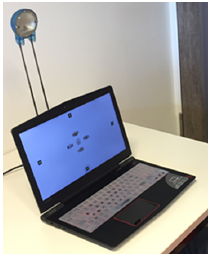
Figure 7 . The experiment